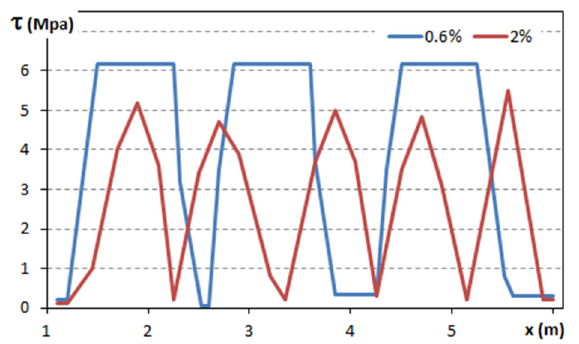
Figure 16. Effect of reinforcement ratio on the distribution of shear stresses for the structures with two steel